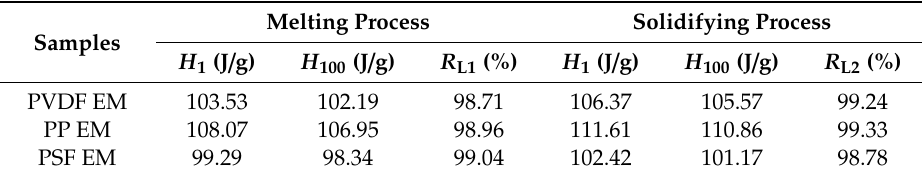
Figure 8 . Cyclic reliability of three encapsulation membranes; ( a ) is PVDF EM; ( b ) is PP EM; ( c ) is PSF EM. Table 3. Latent heat retention rate ( R L ) of three encapsulation membranes; H 1 is latent heat of 1 st thermal cycle; H 100 is latent heat of 100th thermal cycle; R L is latent heat retention